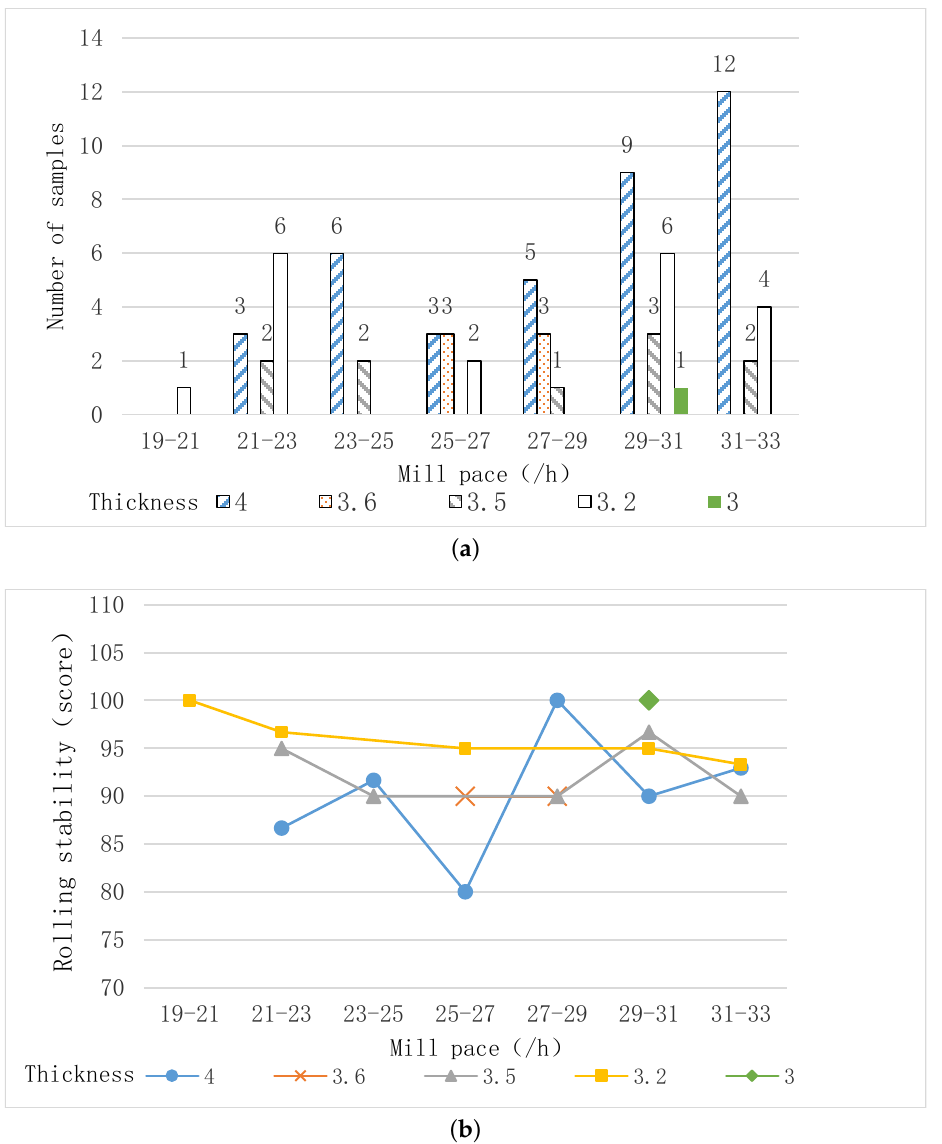
Figure 6. Rolling rhythm. ( a ) Sample distribution; ( b ) Stability